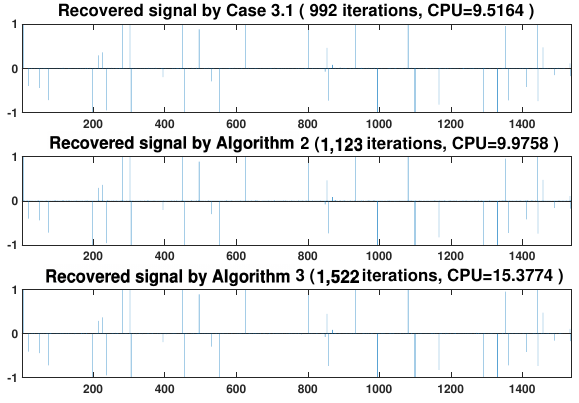
Figure 14. Recovered signal by Algorithms 2, 3 and 7 inputting A 1 , A 2 and A 3 , respectively.